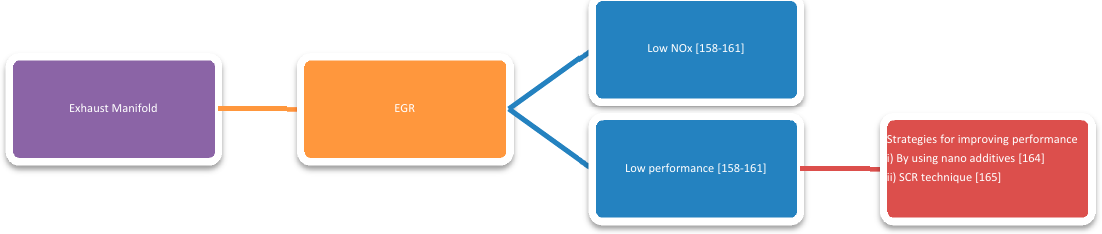
Figure 9. Schematic diagram of Exhaust manifold